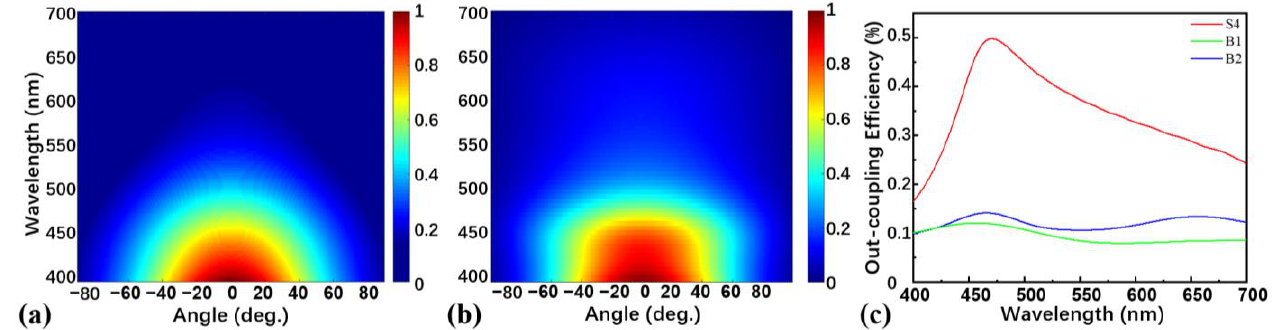
Figure 4. FDTD simulation of angle-wavelength-dependent normalized emission intensities of ( a ) device B1 and ( b ) device B2; ( c ) FDTD simulation of light out-coupling efficiencies of devices B1, B2, and S4.